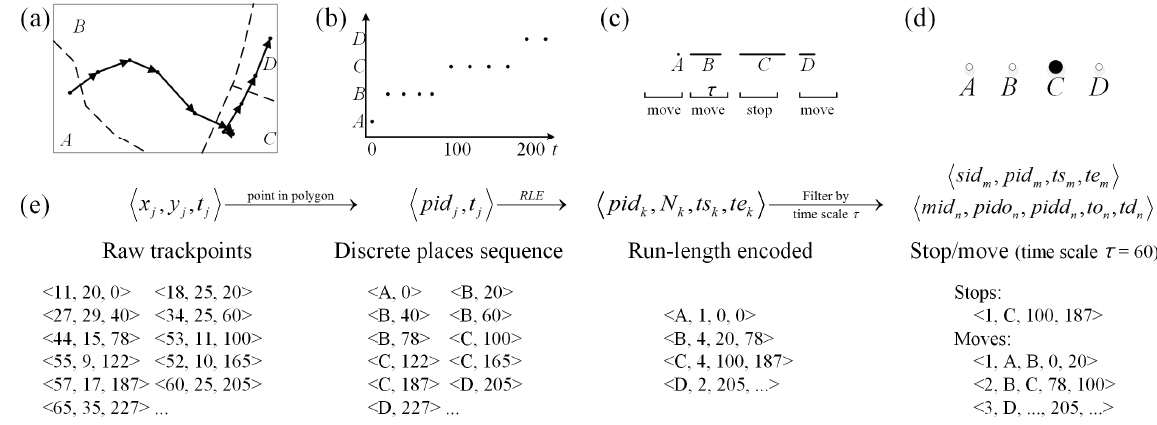
Figure 1. Representation of trajectories for the mobility pattern extraction.( a ) A trajectory passes by areas from A to D. ( b ) The trajectory is represented as discrete area labels and corresponding time. ( c ) The consecutive stay in each area is considered as an episode in run-length encoding scheme. The length of horizontal line represents its duration. An episode is considered as a stop if it is longer than the time scale τ (capped lines), otherwise a move. ( d ) The trajectory is represented as a sequence of areas with stop (solid dot) or move (open dot) labels. ( e ) Corresponding data representations for (a) to (d).